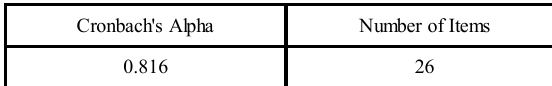
causes have been assigned ranks in relation to their Mean TABLE 4. RELIABILITY STATISTICS